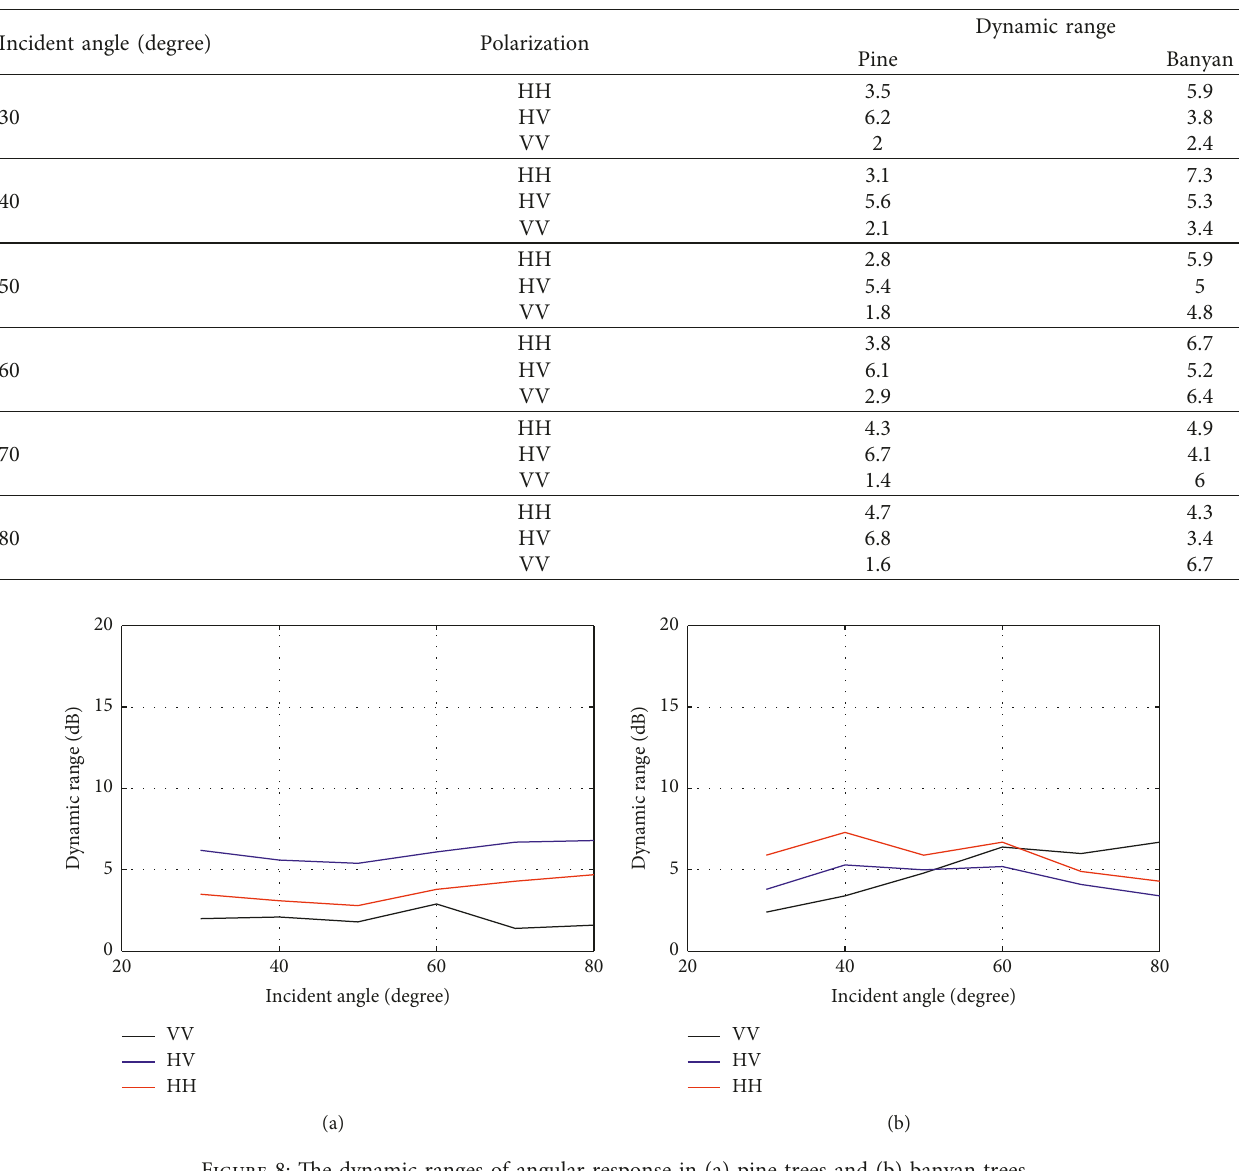
Table 4: The dynamic range of the pine tree and banyan tree from 28GHz to 36GHz for VV, HV, and HH polarizations.